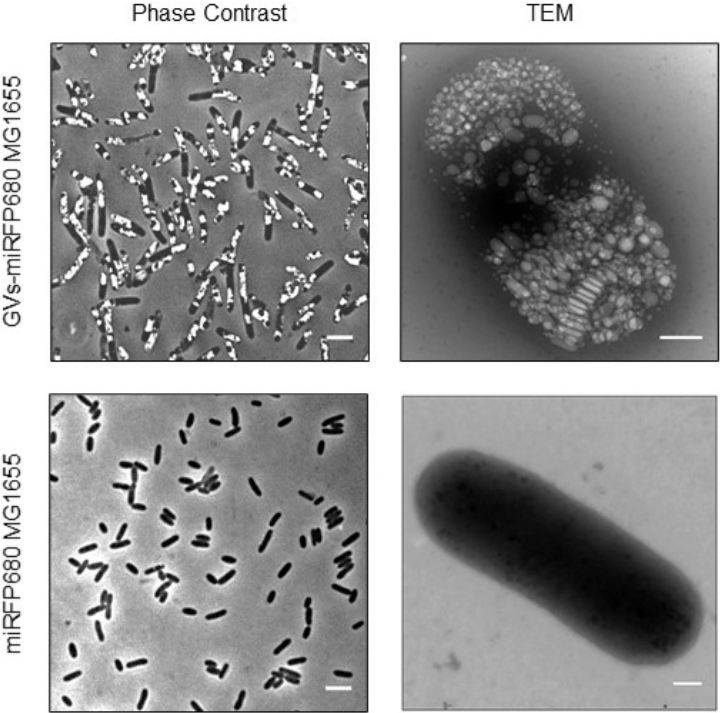
Figure 2. The characteristics of GVs-miRFP680 MG1655. The engineered bacteria GVs-miRFP680 MG1655 filled with GVs ( upper ) and the control group bacteria miRFP680 MG1655 ( lower ). Scale bars = 5 µm. Transmission electron microscope (TEM) images ( right ) depict the distribution of GVs inside GVs-miRFP680 MG1655 ( upper ) and miRFP680 MG1655 ( lower ). Scale bars = 200 nm.